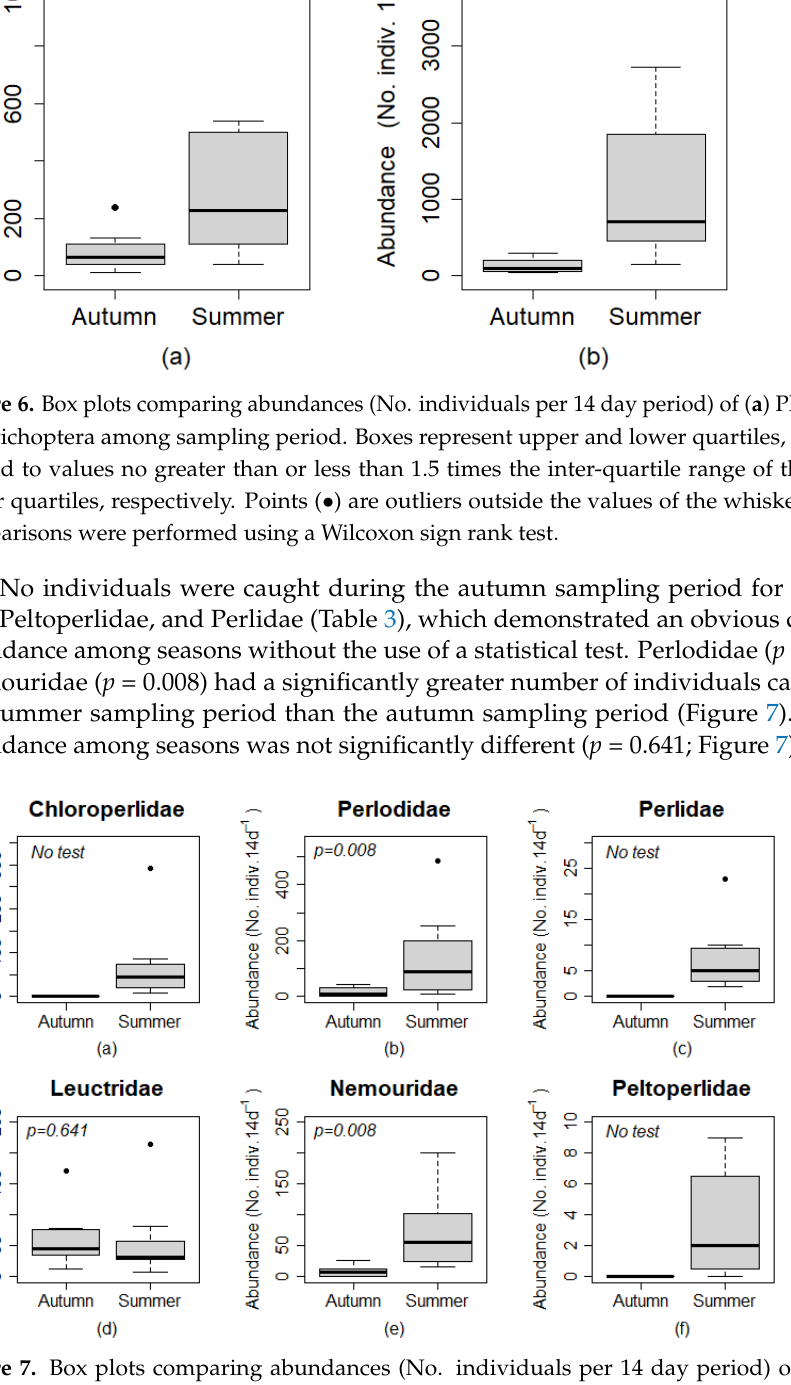
Figure 7. Box plots comparing abundances (No. individuals per 14 day period) of plecopteran families ( a–f ) among sampling period. Boxes represent upper and lower quartiles, and whiskers extend to values no greater than or less than 1.5 times the inter-quartile range of the upper and lower quartiles, respectively. Points (•) are outliers outside the values of the whiskers. Statistical comparisons were performed using a Wilcoxon sign rank test.